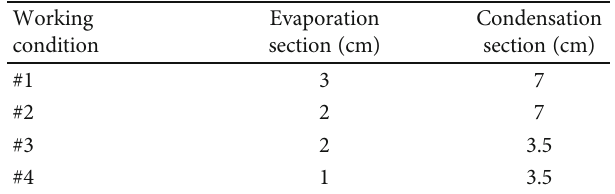
Table 1: Various combinations of di ff erent evaporator and condenser